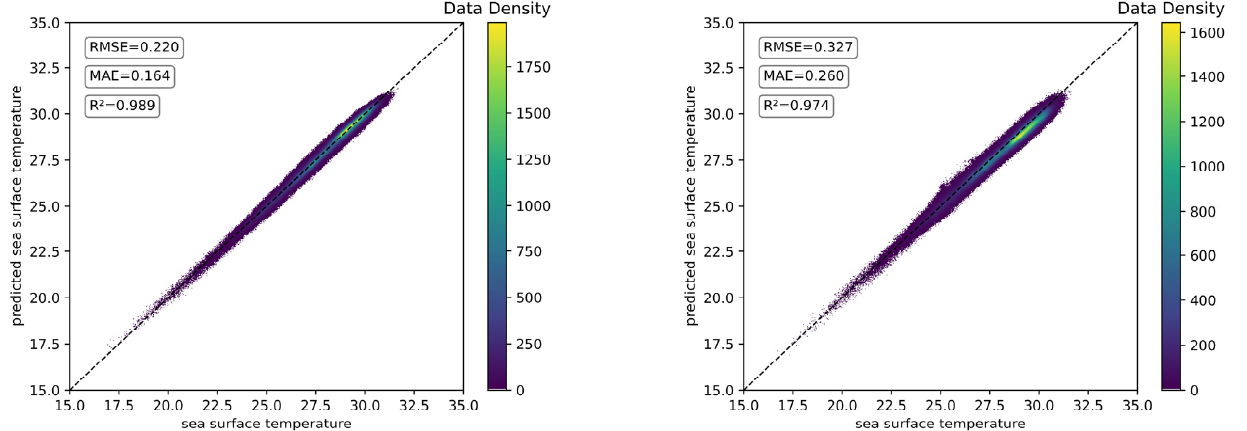
Figure 9. Comparison of SST prediction performance using ST-ConvLSTM. On the left, the prediction length is set to 1, and on the right, it is set to 15.